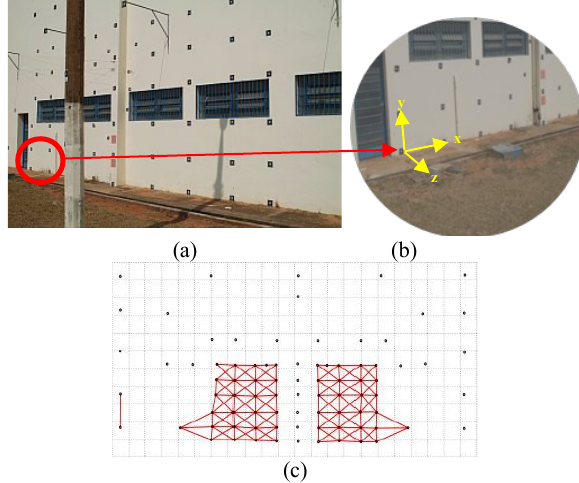
Figure 3. (a) Image of the calibration field; (b) origin of the arbitrary object reference system; and (c) existing targets and distances directly measured with a precision calliper for quality